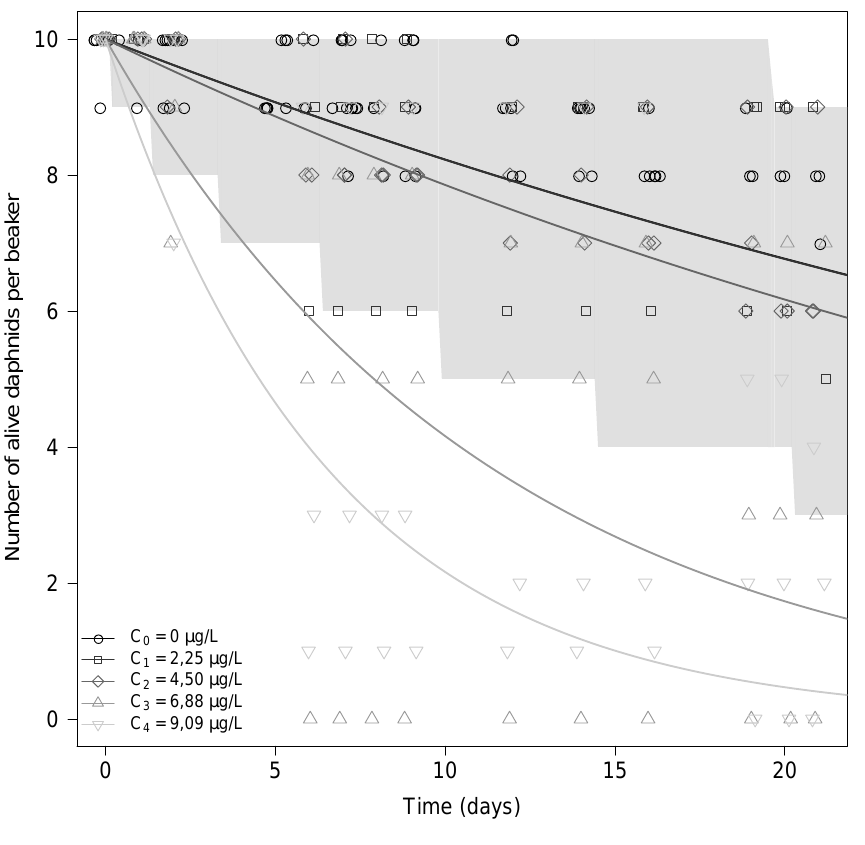
Figure 3. Fit plot for the number of alive daphnids per beaker. Symbols refer to the different tested cadmium concentrations of Experiment 5. Plain lines stand for the fitted model with each parameter equal to its median value at each concentration C j . The light grey area corresponds to the 95% credible band of the predicted data in the